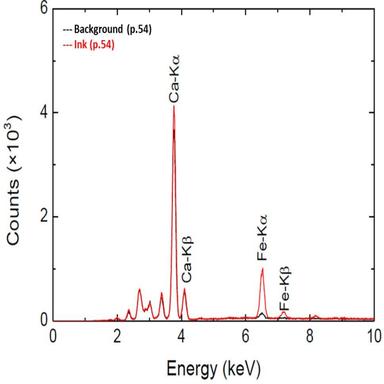
Comparison of XRF spectra of the not written part (black line) and the written part (red line) of the manuscript 157 (page 54).